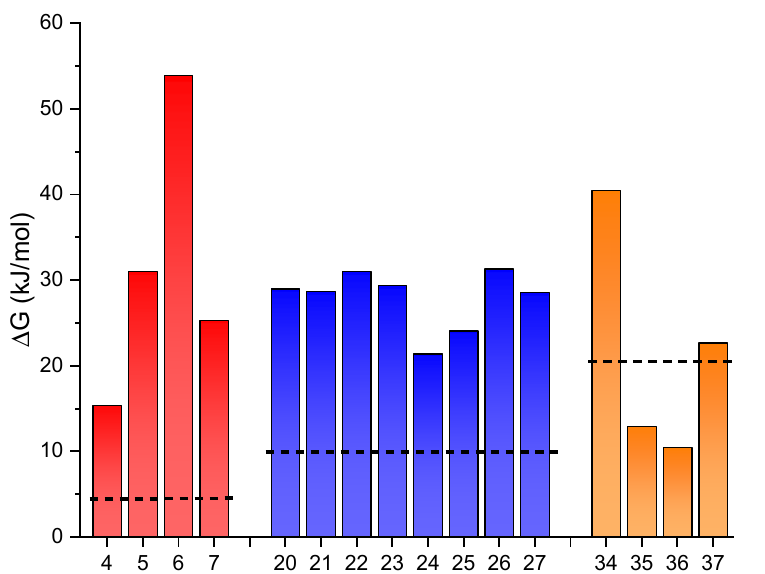
Figure 4. Energy difference between isomers for photoswitches with hydrogen bonds ( 4 – 7 hydan- toins, 20 – 27 oxazolones, 34 – 37 arylidene-pyrrolinone). The dashed line represents the system without hydrogen bonds (phenyl group) in each case. In all cases the most stable is the Z -isomer, and only in compound 7 is the E -isomer more stable.